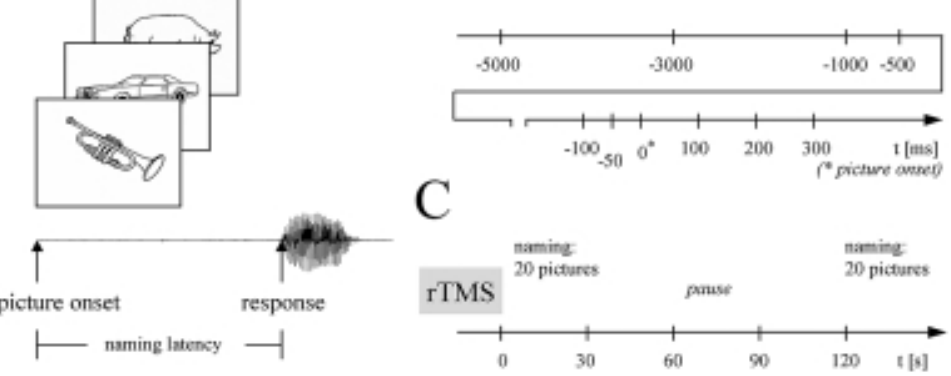
Fig. 1. Experimental design: A Black-and-white line drawings [37] were presented to the subjects. Naming latency was defined as the latency between picture onset and the first detectable amplitude in the digitized speech-wave envelopes. B In the single pulse-experiments [41] TMS was applied prior to and post picture onset, defined as negative and positive values of the interstimulus interval (ISI), respectively. C In the rTMS experiments [23,38] subjects had to name blocks of 20 pictures immediately and 2 min after the end of the high-frequency (20 Hz) or low-frequency (1 Hz)